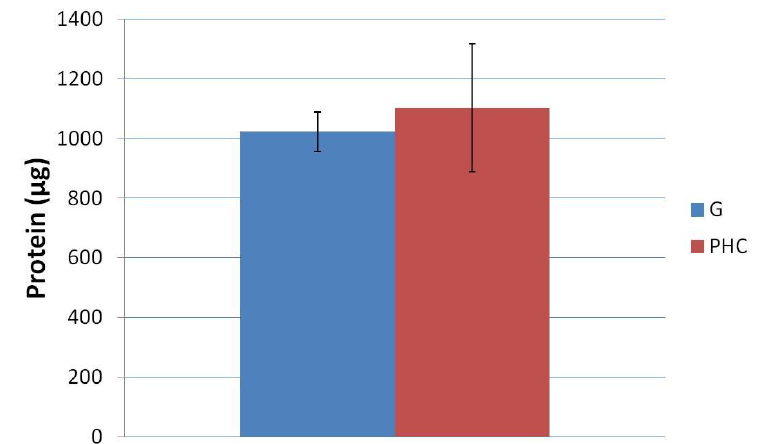
Figure 4. Original total protein content of non-cross-linked scaffolds. All scaffolds reported statistically similar values or original protein